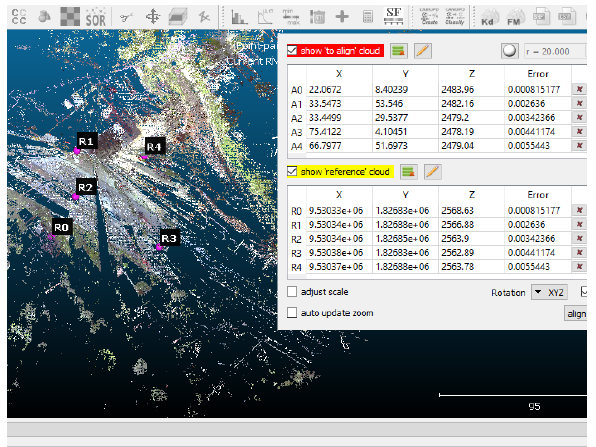
Figure 3 Error values in the alignment of the upper and lower zones for the study area